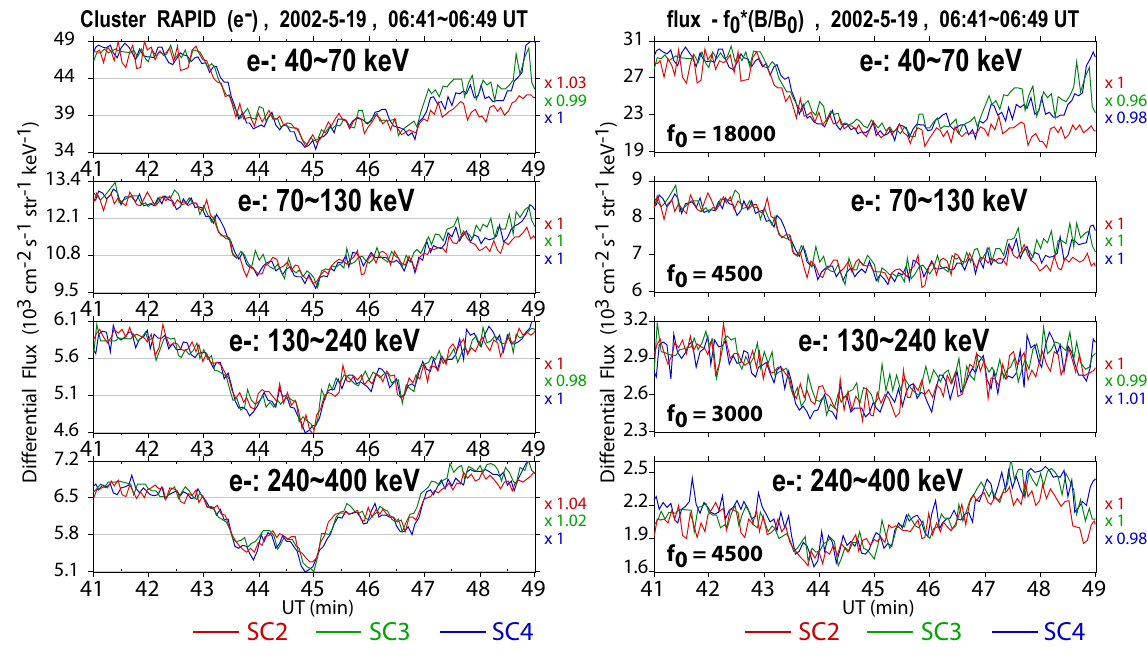
Fig. 10. (a) The same as Fig. 9 but for electron data. (b) Linearly separated profiles of the observed electron flux from the variation that is proportional to the magnetic field variation assuming flux = f 0 + f 1 × (dB/B 0 ) , where dB = B − B 0 , and B 0 =190nT is the magnetic field at the start of the event